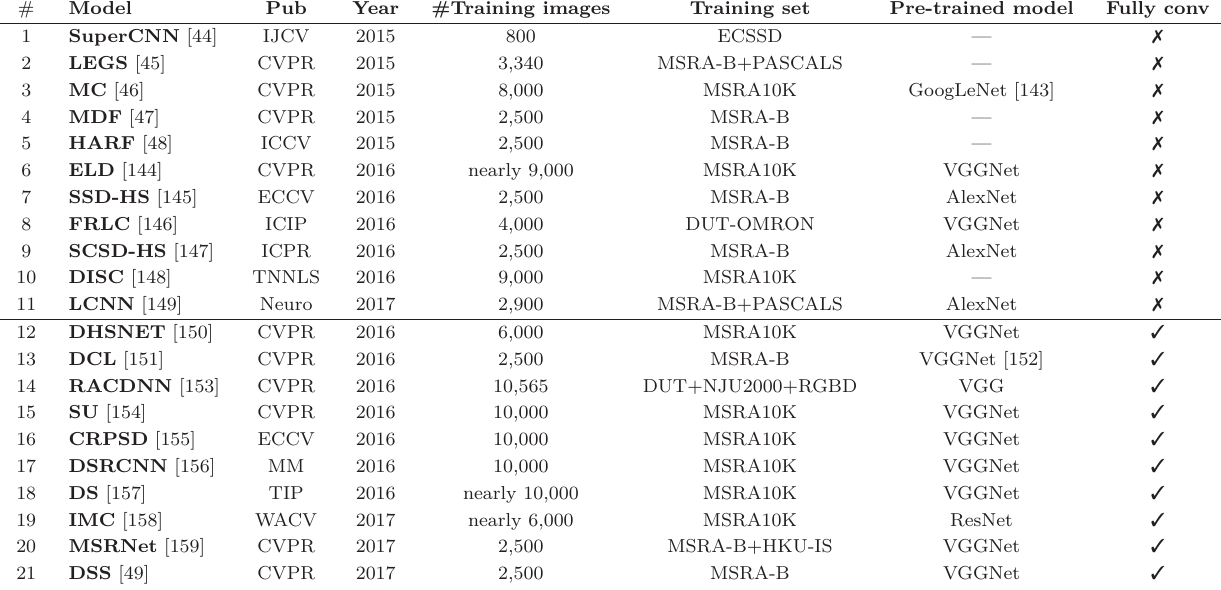
Table 4 CNN-based salient object detection models and information used by them during training. Above: CCN-based models. Below: FCN-based models #